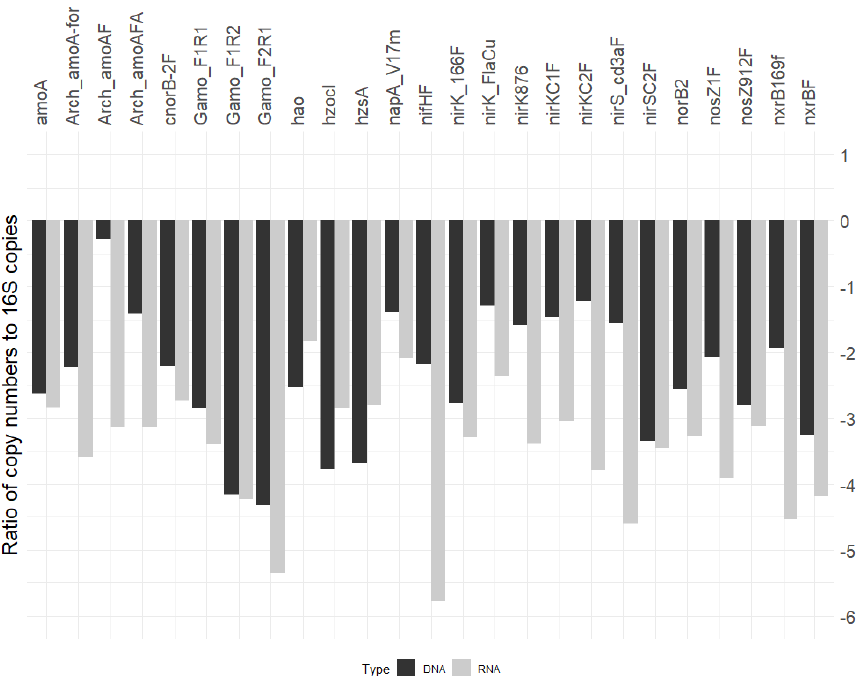
Figure 4. Proportion of N – cycle gene copy numbers and transcript quantities to total bacterial/archaeal biota as measured by bacterial and archaeal 16S rRNA gene qPCR, expressed as log 10 .